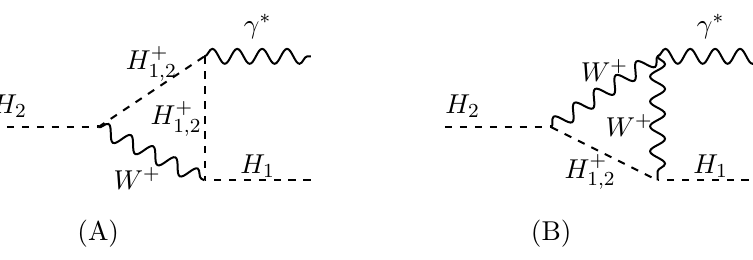
Figure 3 . Triangle diagrams contributing to the H 2 ! H 1 (cid:13) (cid:3) decay, where the lightest inert is absolutely stable and hence invisible, while (cid:13) (cid:3) is a virtual photon that couples to fermion-